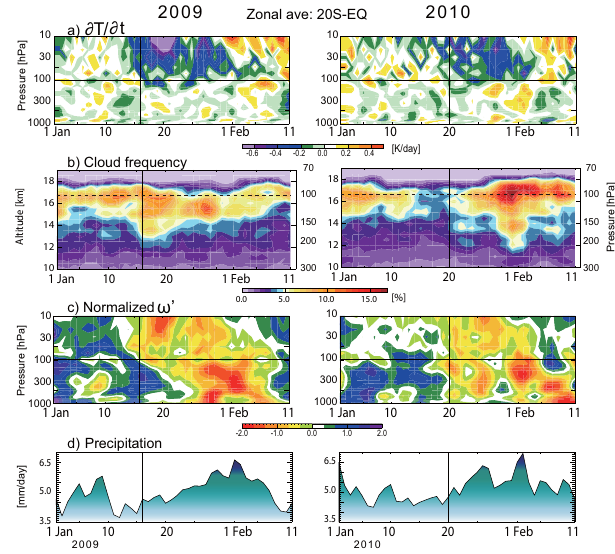
Figure 3. (a) Similar to Fig. 1 except for the pressure–time section of the zonal mean temperature tendency averaged over the SH trop- ics (20 ◦ S to the Equator) (Kday − 1 ). (b) As for panel (a) except for the geographical altitude–time section of cloud frequency mea- sured by CALIOP (%). (c) As for panel (a) except for the pressure coordinate vertical velocity anomalies normalized by the standard deviation of daily variability. (d) Time series of the daily TRMM surface precipitation averaged over SH tropics (mmday − 1 ). Hori- zontal solid lines in panels (a) and (c) and dashed lines in panel (b) indicate 100hPa pressure